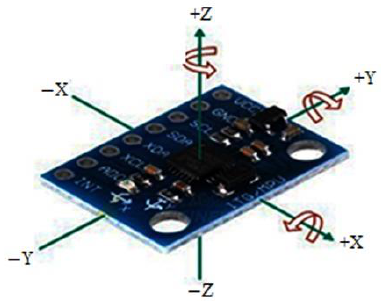
Figure 3. MPU6050 orientation and polarity rotation.